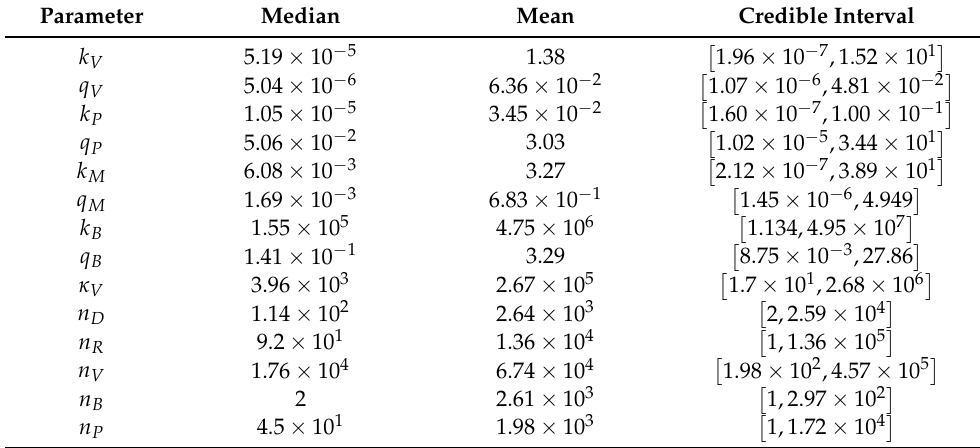
Table 5. Summary statistics for each accepted parameter value sets from model 2. Mean, median and a 95% credible interval are summarised in the table.